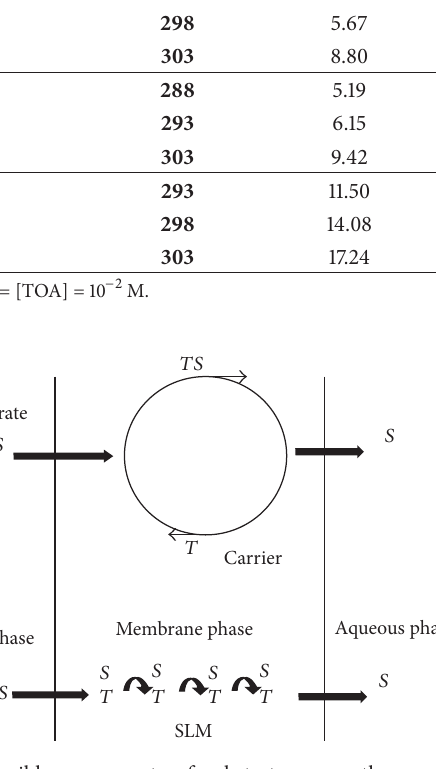
Table 6: All values of microscopic parameters 𝐾 VO 2+ ions.